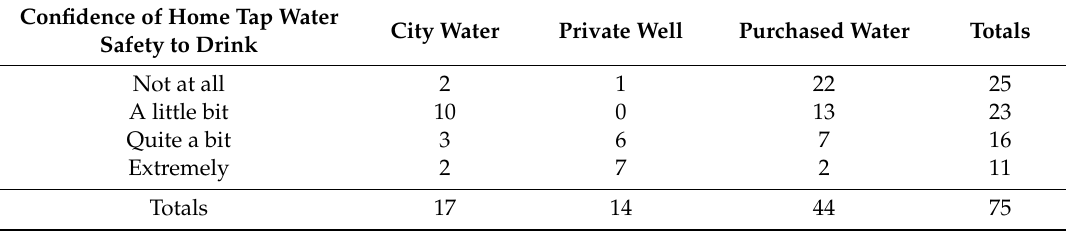
Table 7. Results of the cross-tabulation of safety of water to drink versus source of drinking water. Confidence of Home Tap Water